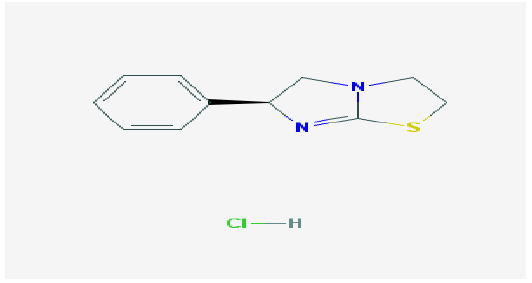
Figure 1. Chemical structure of levamisole [1].